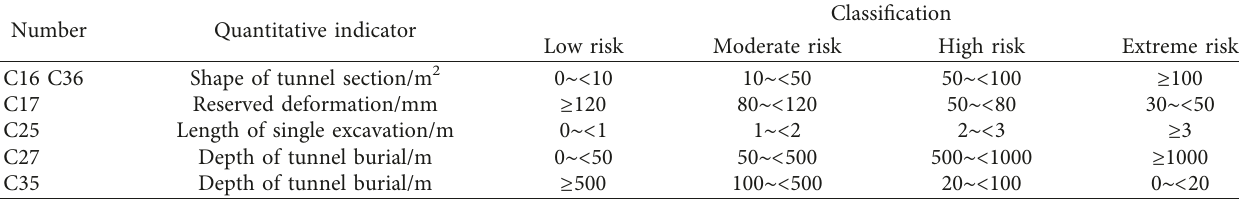
Table 3: Classification of a quantitative risk